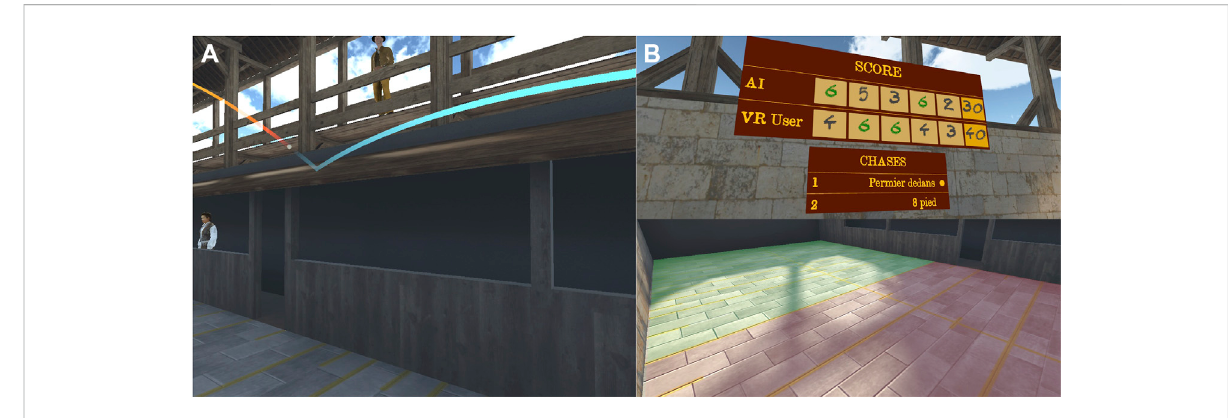
FIGURE 10 Left: Visualization of the trajectory of the ball; Top right: Scoreboard; Bottom right: Visualization of the active chase area.